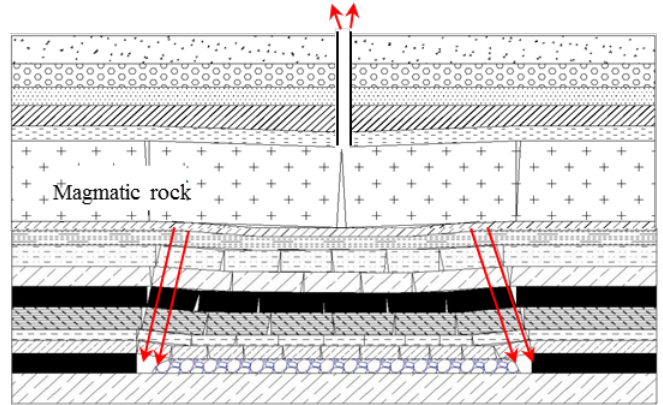
Figure 10. Schematic diagram of bed separation gas inrushing.